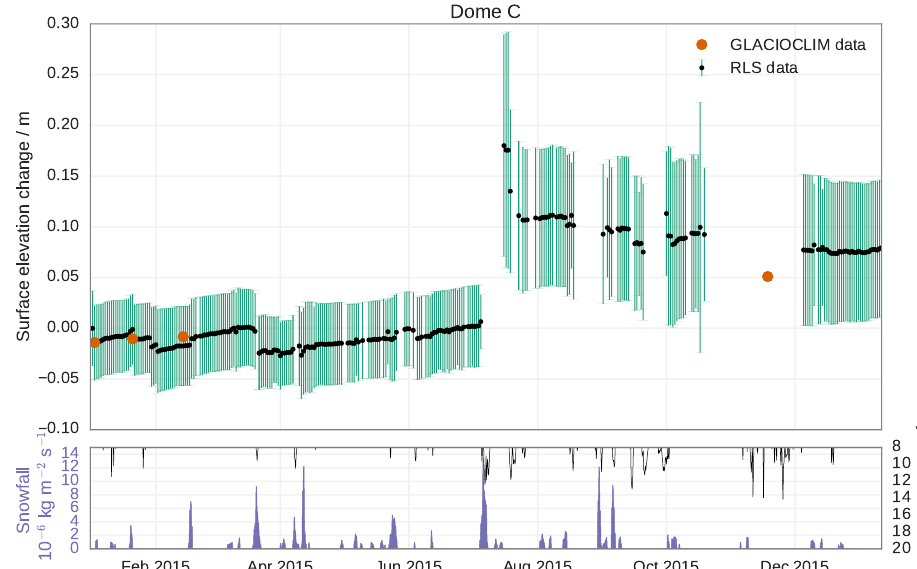
Figure 4. Evolution of the mean (black) and standard deviation (green) of the surface elevation change at Dome C in 2015 and January 2016 measured by the RLS. Orange points show the mean accumulation deduced from emergence measurements of the GLACIOCLIM 50-stack network. The reference is calculated so that the first GLACIOCLIM measurement (3 January 2015) equals the mean RLS snow elevation measured the same